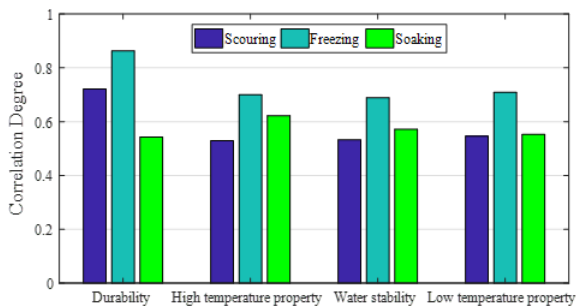
Figure 12. Calculation results of NHSS-AC by the gray rational degree theory.